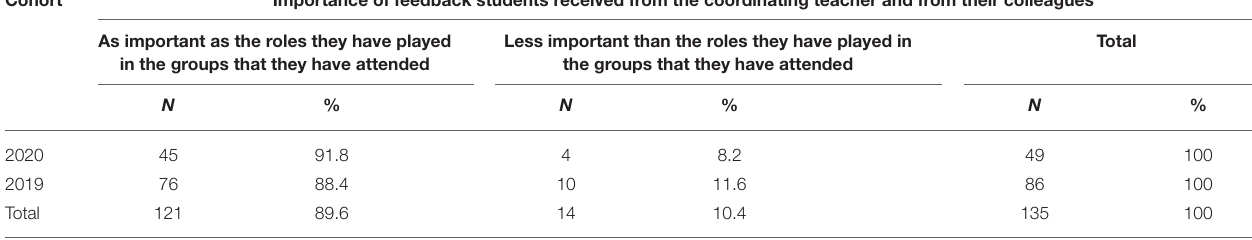
TABLE 4 | The importance of feedback as a way of learning. Cohort